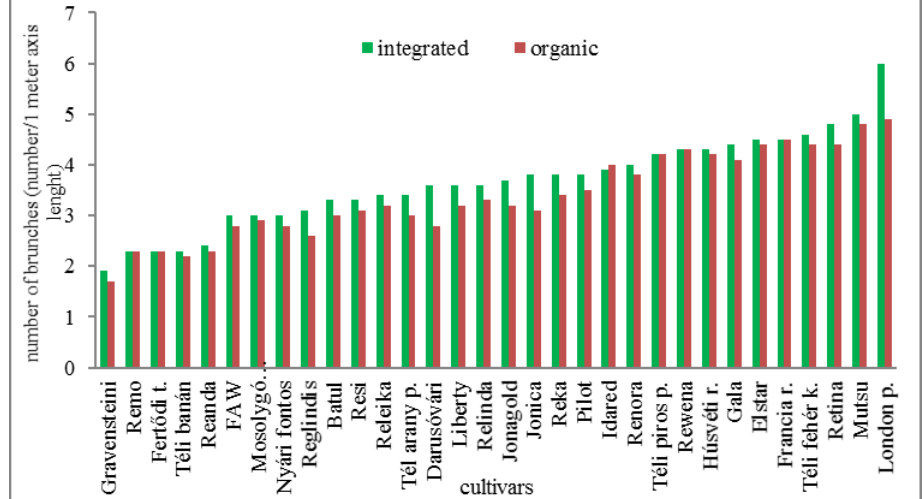
Figure 2. Number of branches of the central axis in the lower third of the canopy (Debrecen-Pallag, 2010)